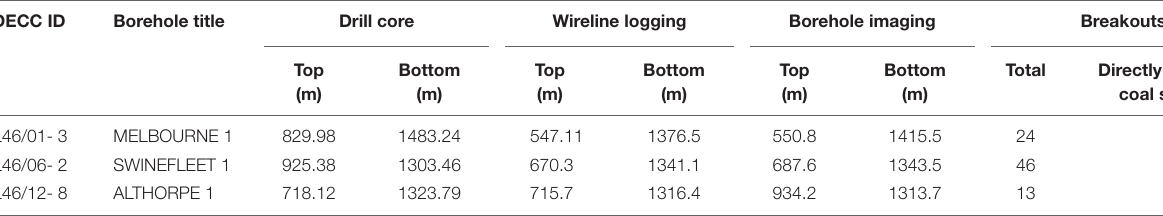
TABLE 1 | Summary information for Coal Bed Methane boreholes in North Yorkshire.